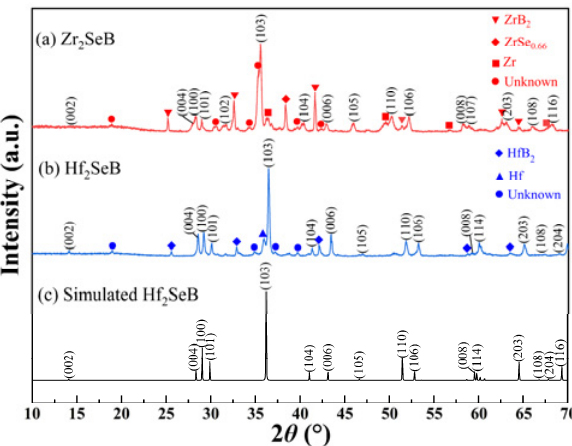
Fig. 4 XRD patterns of experimentally synthesized (a) Zr 2 SeB and (b) Hf 2 SeB samples as well as (c) simulated XRD pattern of Hf 2 SeB.